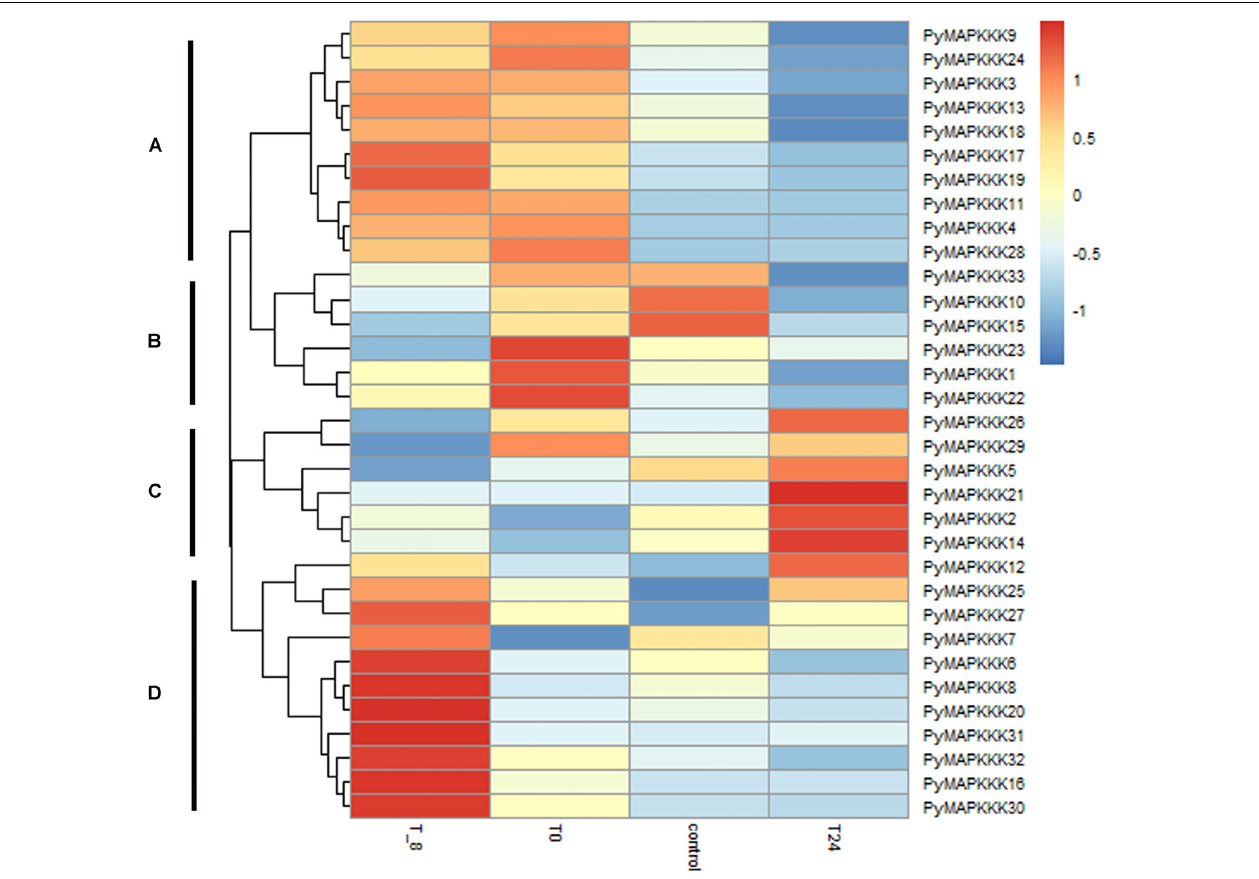
FIGURE 6 | Hierarchical clustering of the expression profiles of all 33 PyMAPKKK genes in different temperature stress. Log2-transformed expression values were used to create the heat map. The red or blue color represent the higher or lower relative abundance of each transcript in each sample, compared to the median expression value of that gene in the whole sample set. Genes were clustered (A–D) according to their expression profiles.T_8 represent under –8 ◦ C temperature stress, T0 represent under 0 ◦ C temperature stress, T24 represent under 24 ◦ C temperature stress, control represents the material cultured at 10 ◦